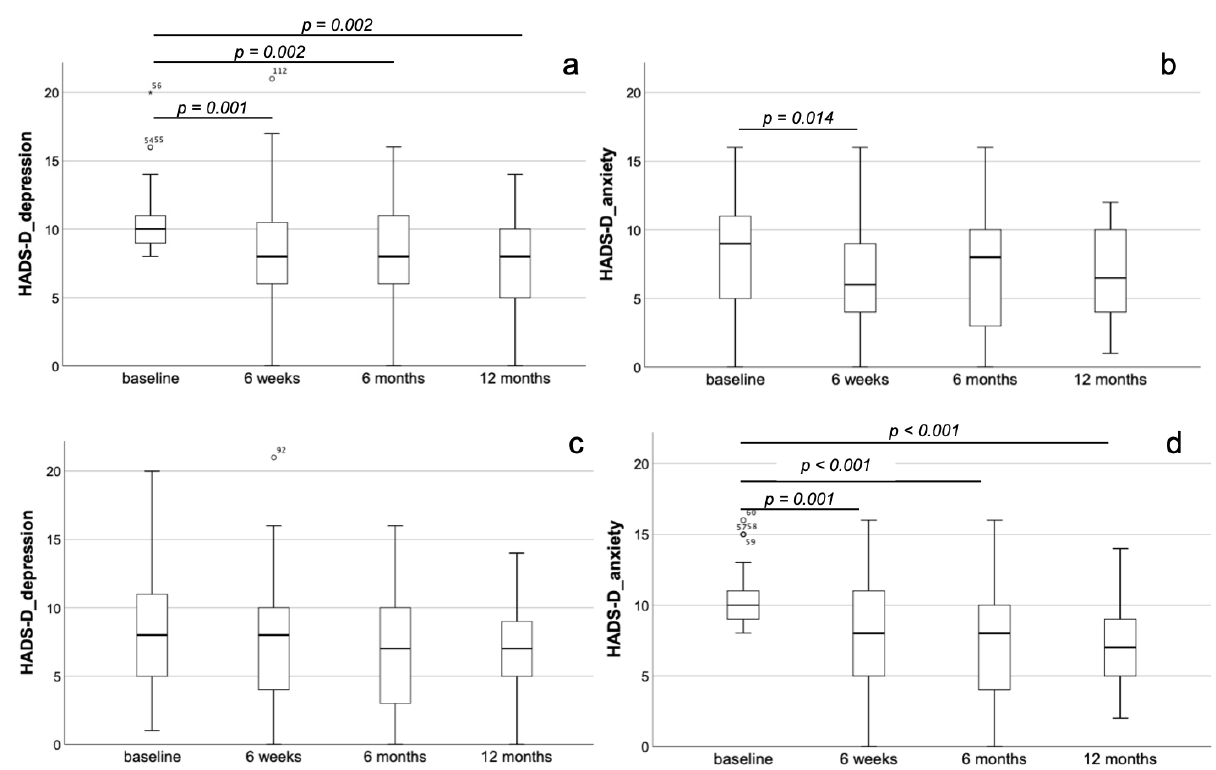
Figure 2. Dynamics of depression and anxiety after TAVI in the entire collective. Development of depression ( a ) and anxiety ( b ) in the depressive subgroup of the entire patients’ collective showing a significant improvement already 6 weeks after TAVI for both depression and anxiety. For depression but not for anxiety, this improvement remained stable even until the 6-month as well as the 12-month follow-up. Development of depression ( c ) and anxiety ( d ) in the anxious subgroup of the entire patients’ collective showing no significant changes with respect to depression but a significant reduction of anxiety 6 weeks after TAVI, remaining stable until the 6-month and the 12-month